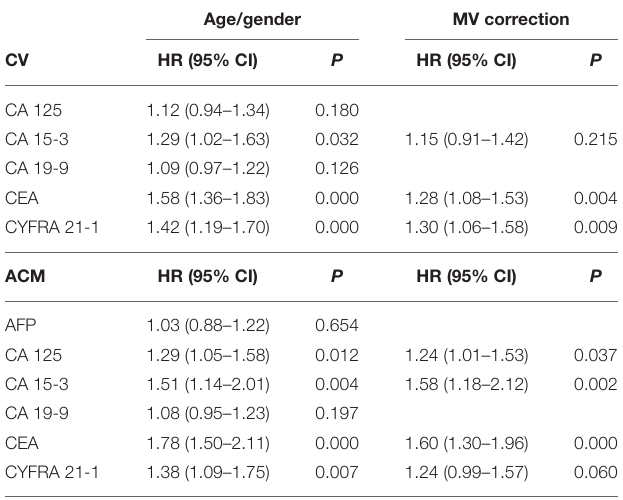
TABLE 4 | Correlation of tumour biomarker levels, CV morbidity and mortality, and ACM.